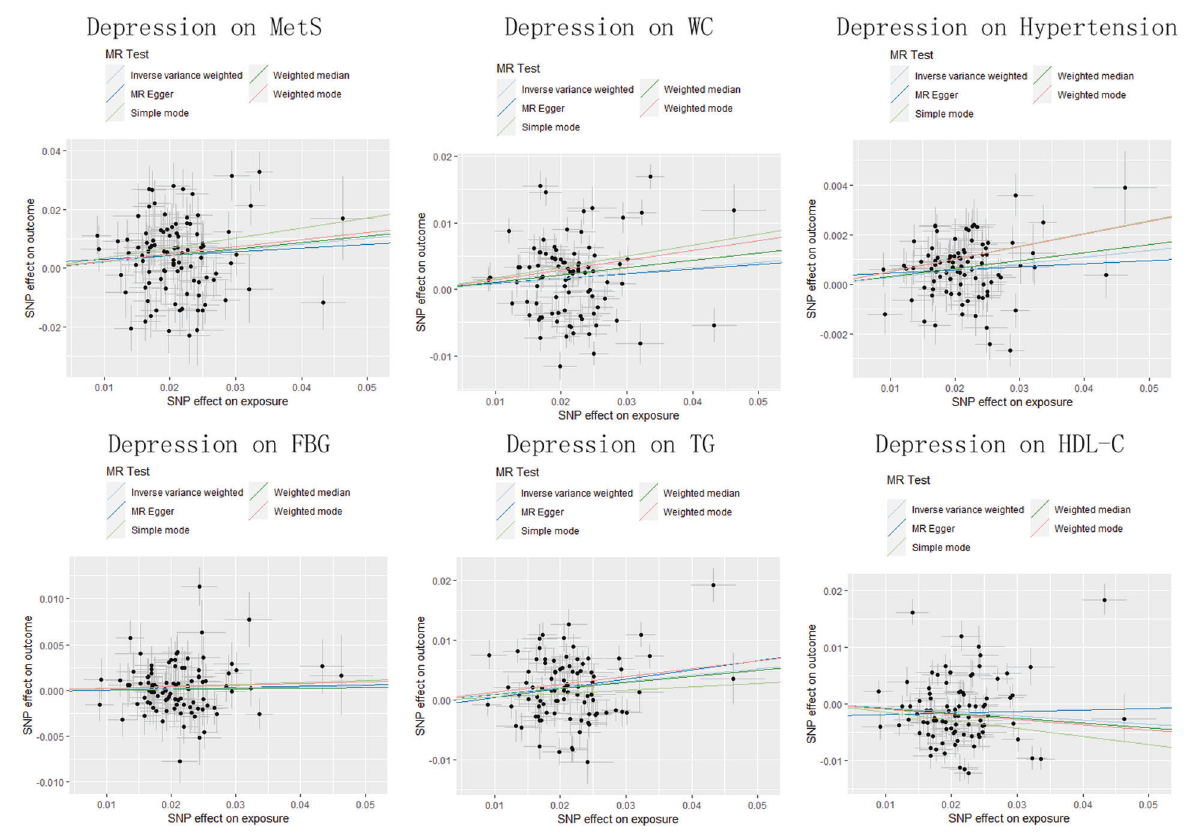
Fig. 2 The scatter plots of the association between genetically predicted depression on MetS and its components. MetS metabolic syndrome, FBG fasting blood glucose, TG triglycerides, WC waist circumference, HDL-C high-density lipoprotein